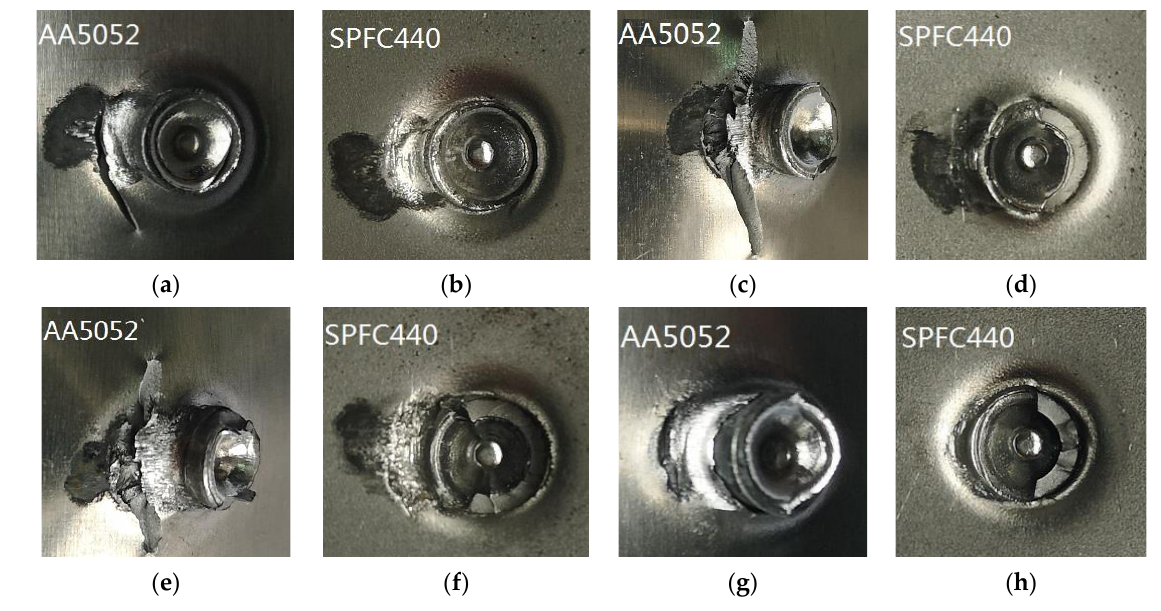
Figure 11. Fretting morphologies of AA-SPFC joints: ( a ) AA5052 with 6 mm rivet; ( b ) SPFC with 6 mm rivet; ( c ) AA5052 with 7 mm rivet; ( d ) SPFC with 7 mm rivet; ( e ) AA5052 with 8 mm rivet; ( f ) SPFC with 8 mm rivet; ( g ) AA5052 with 9 mm rivet; ( h ) SPFC with 9 mm rivet.